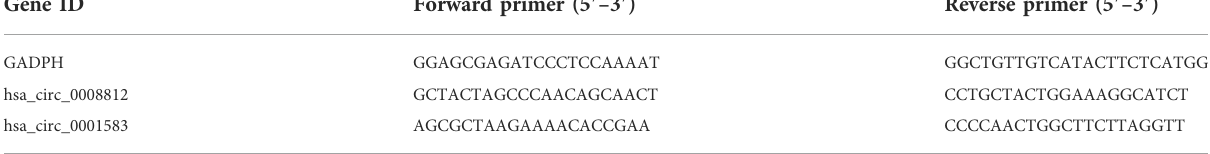
TABLE 2 | Primer sequences of RNAs used for